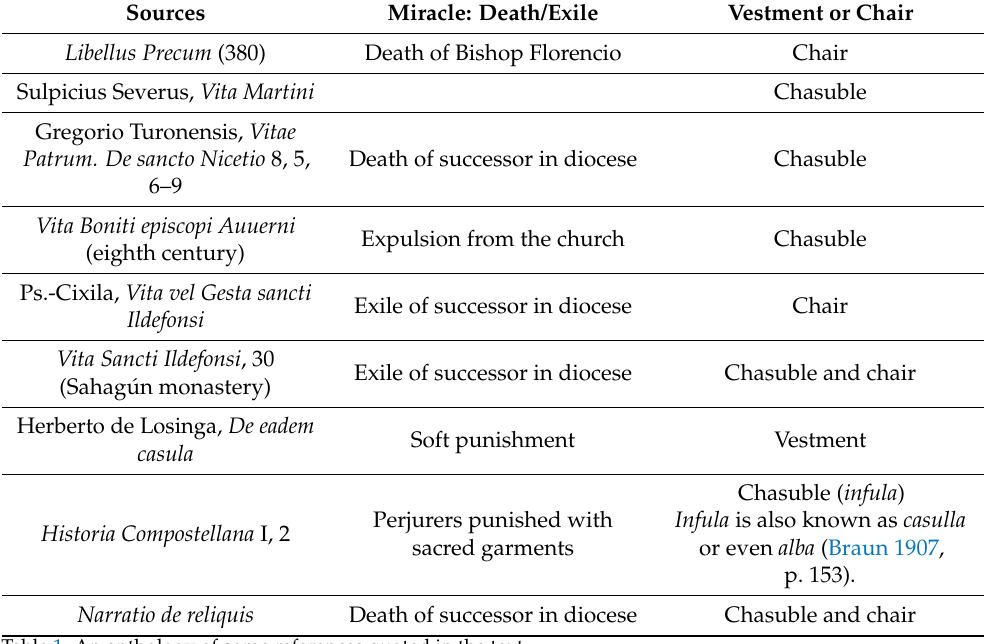
Table 1. An anthology of some references quoted in the